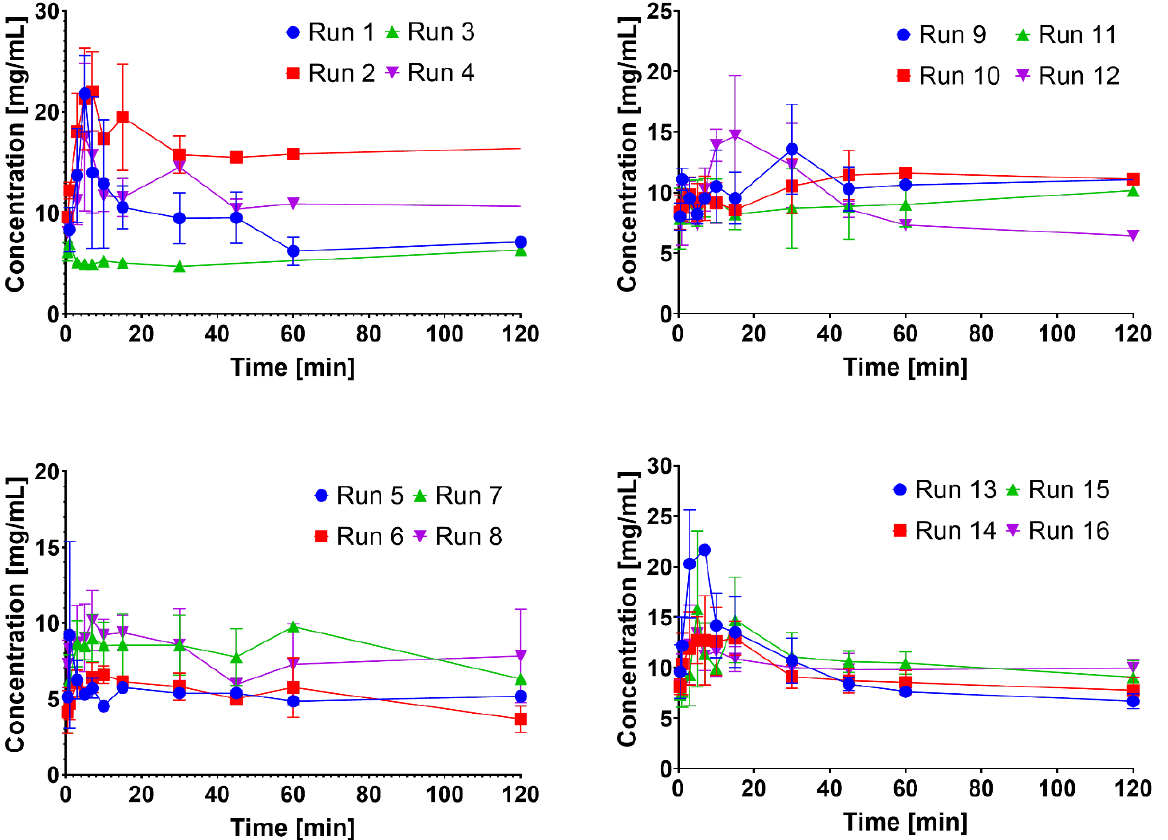
Figure 5. The kinetic solubility of nanocrystal incorporated into mesoporous material using fractional factorial design.